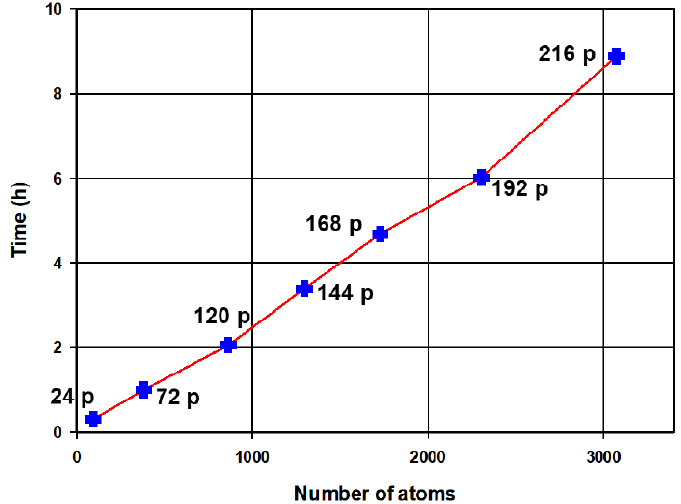
Figure 10. A plot of total computational time versus number of atoms for a LiMn 2 O 4 spinel structure. The single point energy calculations were performed on varying computational resources. The number of processors were varied systematically with the number of atoms.